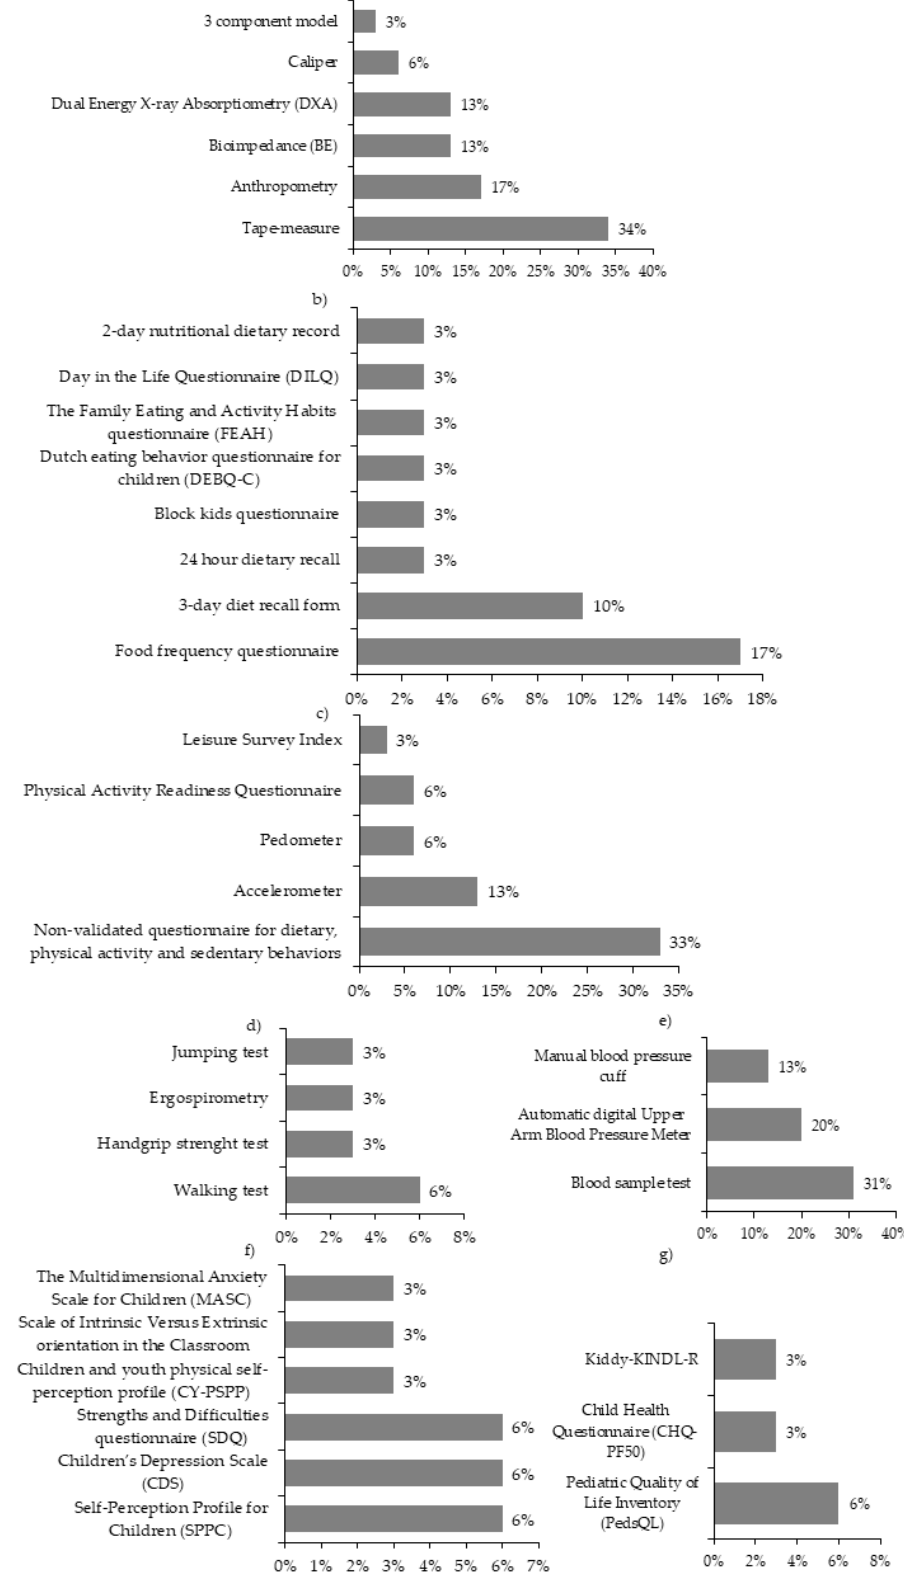
Figure 4. Instruments for the assessment of ( a ) nutritional status, physical and health condition; ( b ) nutrition, ( c ) level of physical activity and sedentary behavior, ( d ) physical condition, ( e ) cardiovascular risk, psychological variables; ( f ) health and ( g ) health-related quality of